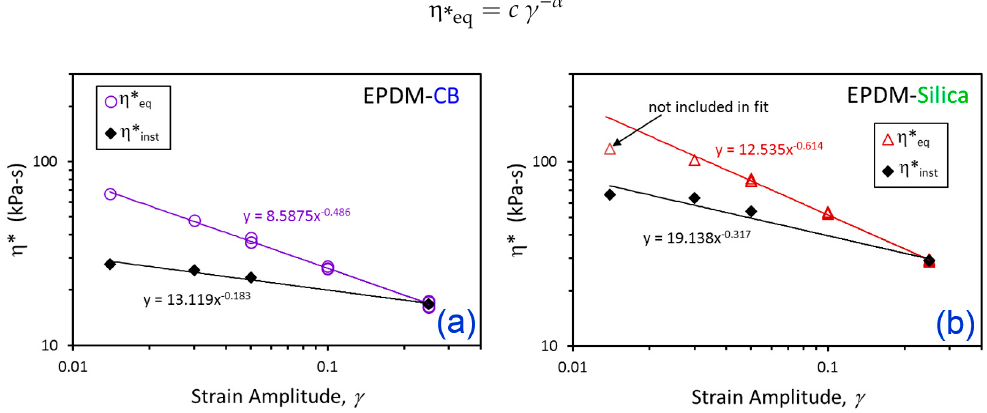
Figure 5. γ -dependent values of η * eq and η * inst (symbols) and power law fits (solid lines) for EPDM-CB ( a ) and EPDM-Silica ( b ). Table 2. Power Law Parameters for γ -dependences of η * eq and η * inst.